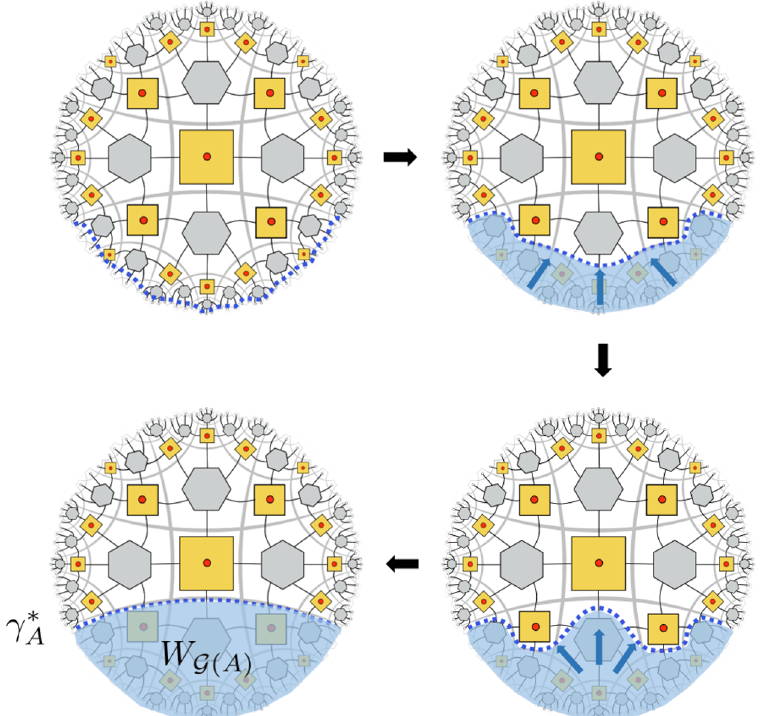
Figure 24. Starting from a boundary region A , we can use the Greedy algorithm to obtain a bulk region that is recoverable from A . Using local moves, the curve γ gradually updated until it reaches the local minimum γ ∗ and the boundary subregion A is the Greedy wedge W